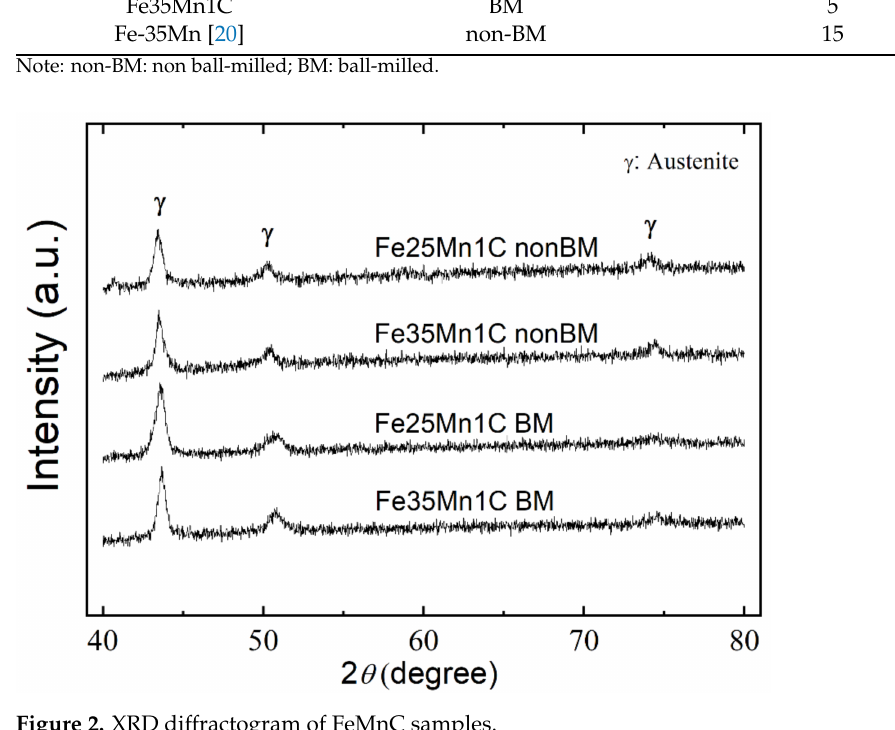
Figure 2. XRD diffractogram of FeMnC samples.